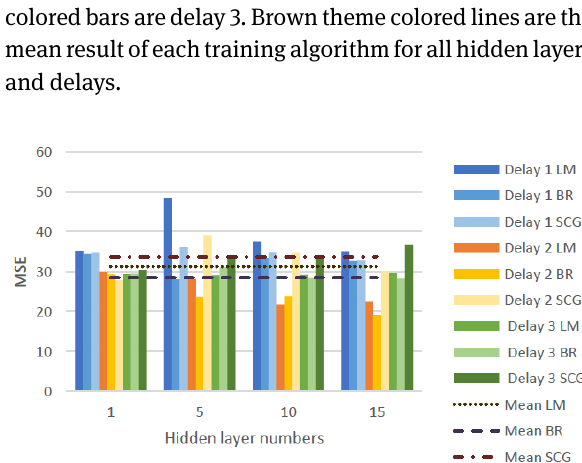
colored bars are delay 3. Brown theme colored lines are the mean result of each training algorithm for all hidden layers and delays.